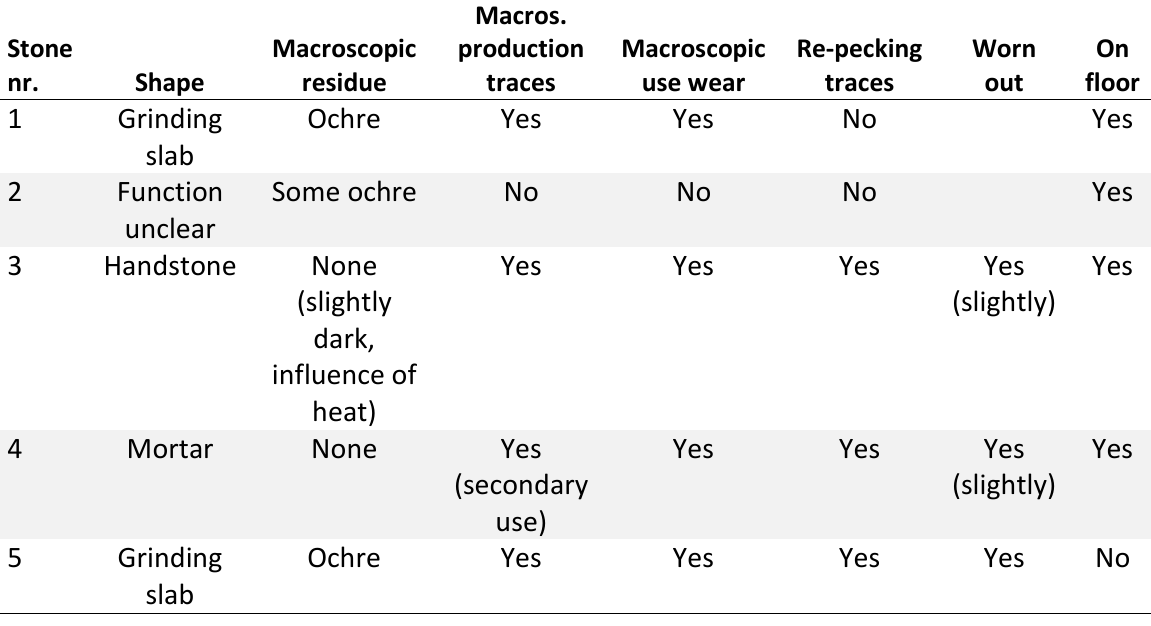
Table 1: Archaeological, macroscopic, and morphological data. Stone nr. Shape